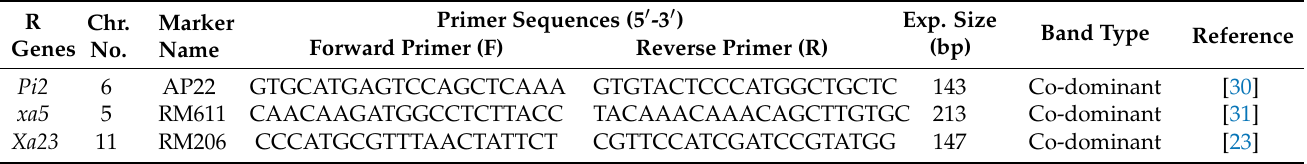
Table 1. Linked markers for foreground selection of Pi2 , xa5 , and Xa23 genes.